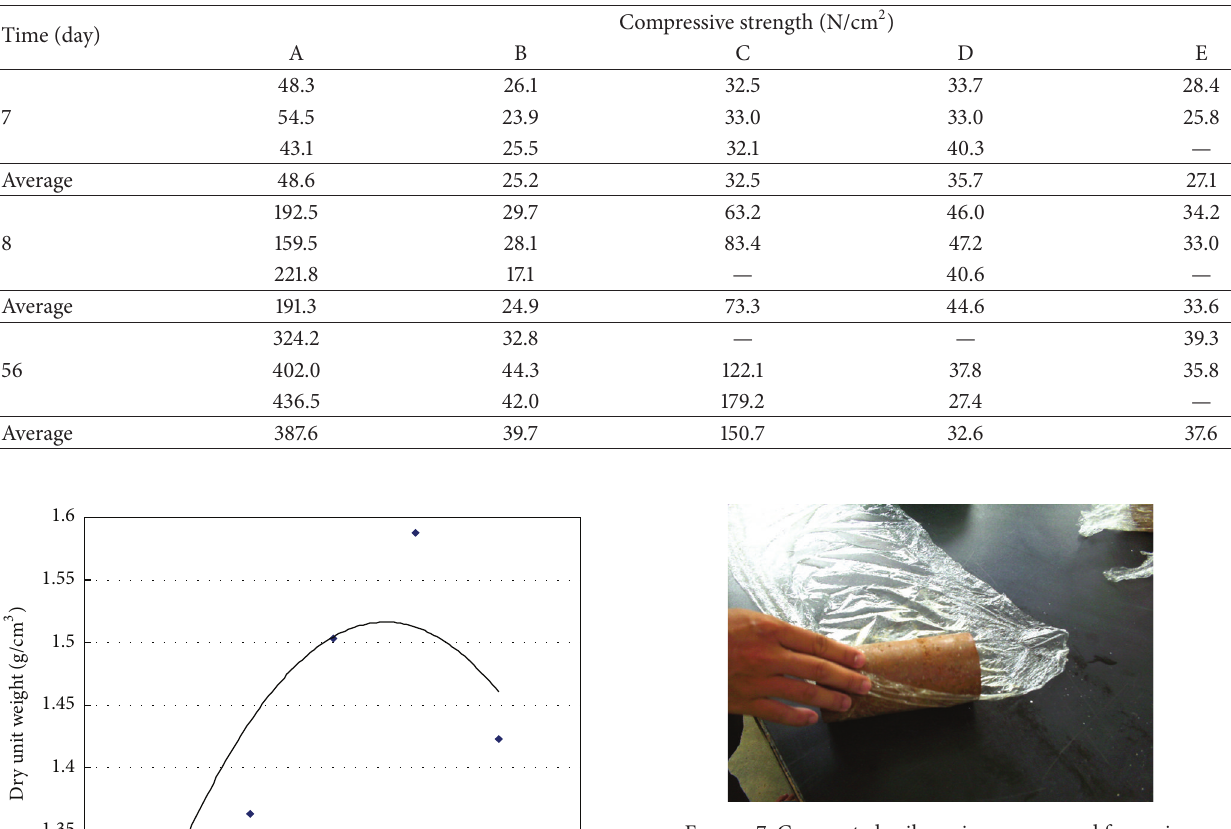
Figure 7: Compacted soil specimens wrapped for